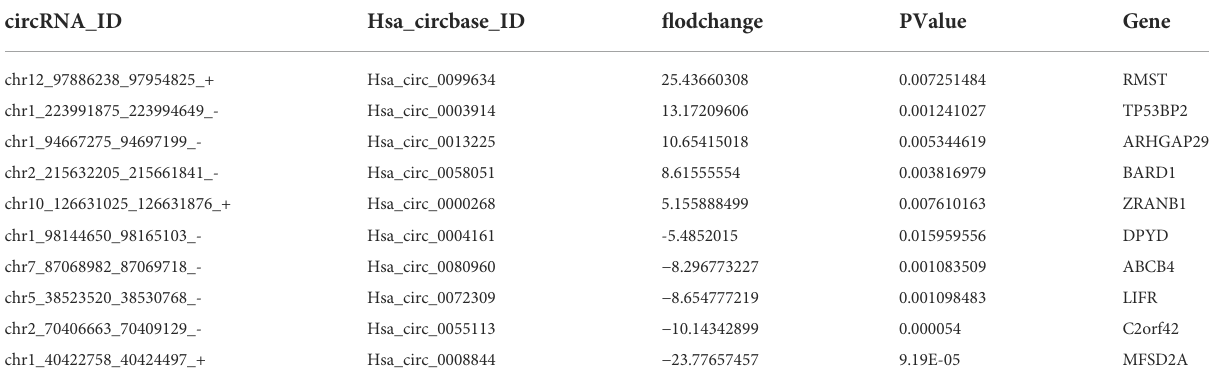
TABLE 1 Top 10 signi fi cantly differentially expressed